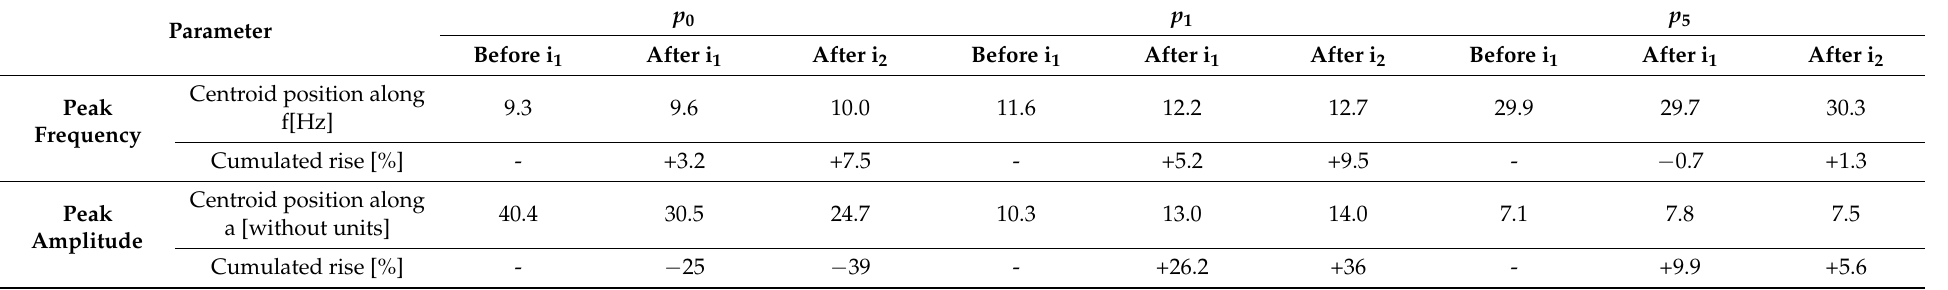
Table A3. HVSR changes between bolting